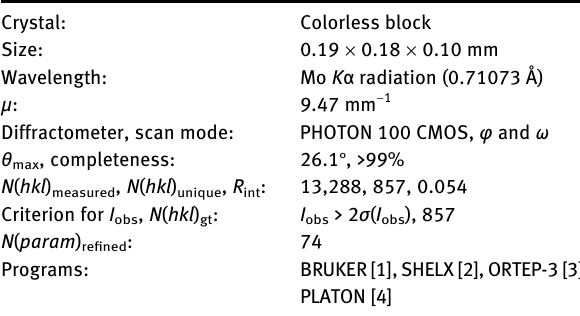
Table  : Data collection and